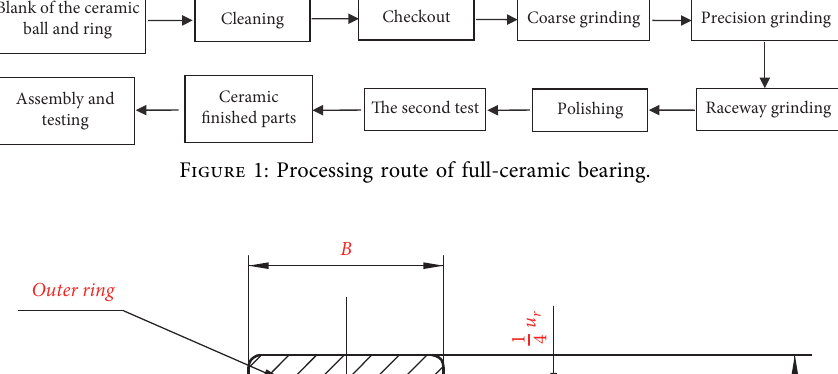
3 N 4 full-ceramic